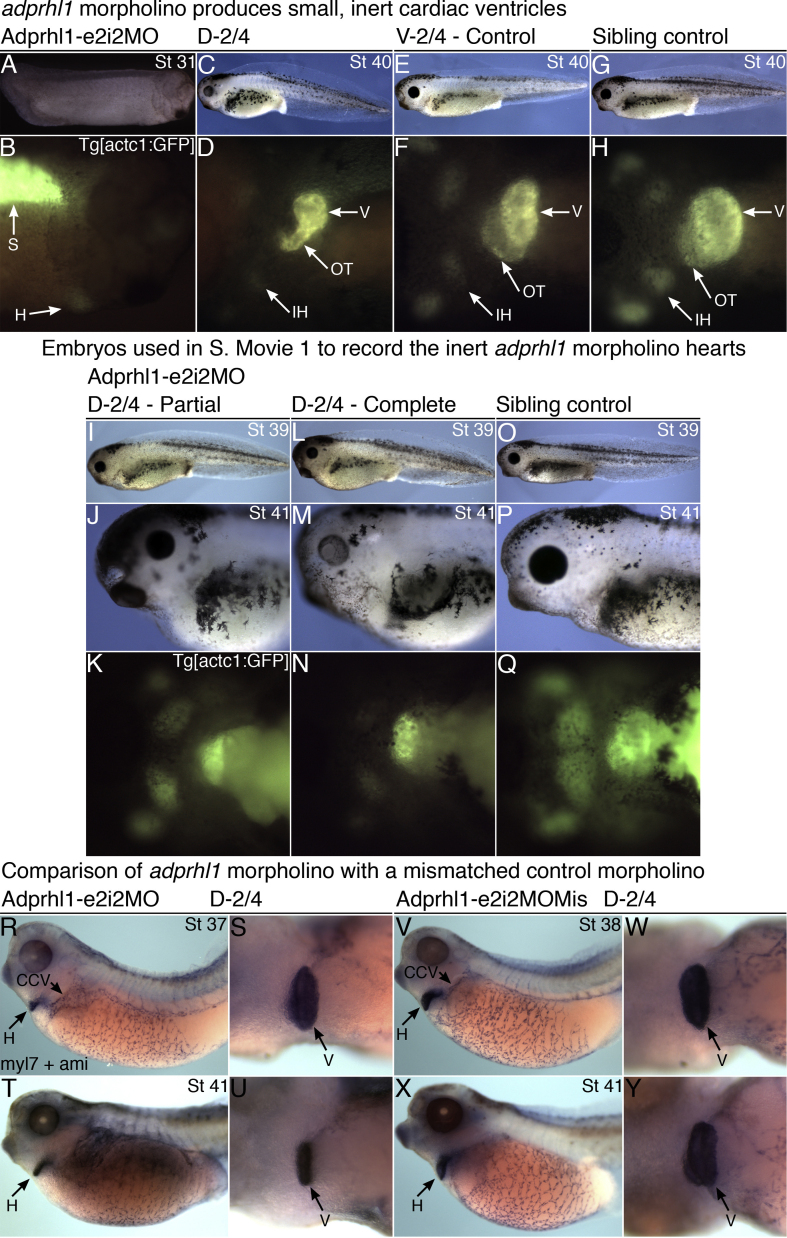
Adprhl1 morpholino produces small, inert cardiac ventricles. A–D: A single tadpole injected with Adprhl1-e2i2MO into D-2/4 blastomeres, shown at stage 31 (A, B) and stage 40 (C, D). The small heart of this tadpole did not contract. E, F: Control tadpole that received the same morpholino into V-2/4 blastomeres. G, H: Sibling control tadpole. Hearts were visualized using the Tg[actc1:GFP] (cardiac actin) reporter transgene. Ventral view of hearts, anterior to left (D, F, H), Right-lateral view (B). H, heart; S, somites; V, ventricle; OT, outflow; IH, interhyoid facial muscle. I–Q Embryos used in S. Movie 1 to record the inert adprhl1 morpholino hearts. I-K: Tadpole with Adprhl1-e2i2MO into D-2/4 blastomeres that has a partial heart beat defect. L–N: A D-2/4-morpholino tadpole with completely inert heart. O-Q: Sibling control. Embryos appear normal at stage 39 (I, L, O) while at stage 41 (J, M, P) when the movies were recorded, oedemas are beginning to form in those with the morpholino. Ventral view of Tg[actc1: GFP] fluorescence (K, N, Q). R–Y: Comparison of adprhl1 morpholino with a mismatched control morpholino. R–U: Tadpoles injected with Adprhl1-e2i2MO into D-2/4 blastomeres showing expression of cardiac myl7 and vascular ami mRNAs. At stage 37 (R, S), there are no apparent differences in cardiac morphology but at stage 41 (T, U), the ventricle is clearly smaller than controls. The oedema does cause a higher background hybridization stain to develop (T). V-Y: Control sibling tadpoles injected with the Adprhl1-e2i2MOMis morpholino that contains 5 mismatched bases. Ventral views, anterior to left (S, U, W, Y). One indirect sign of cardiac dysfunction that can be detected prior to oedema is the broader pattern of ami expression in the common cardinal vein (CCV) region (compare R and V). This is also observed in Fig. 2(A, E, I).